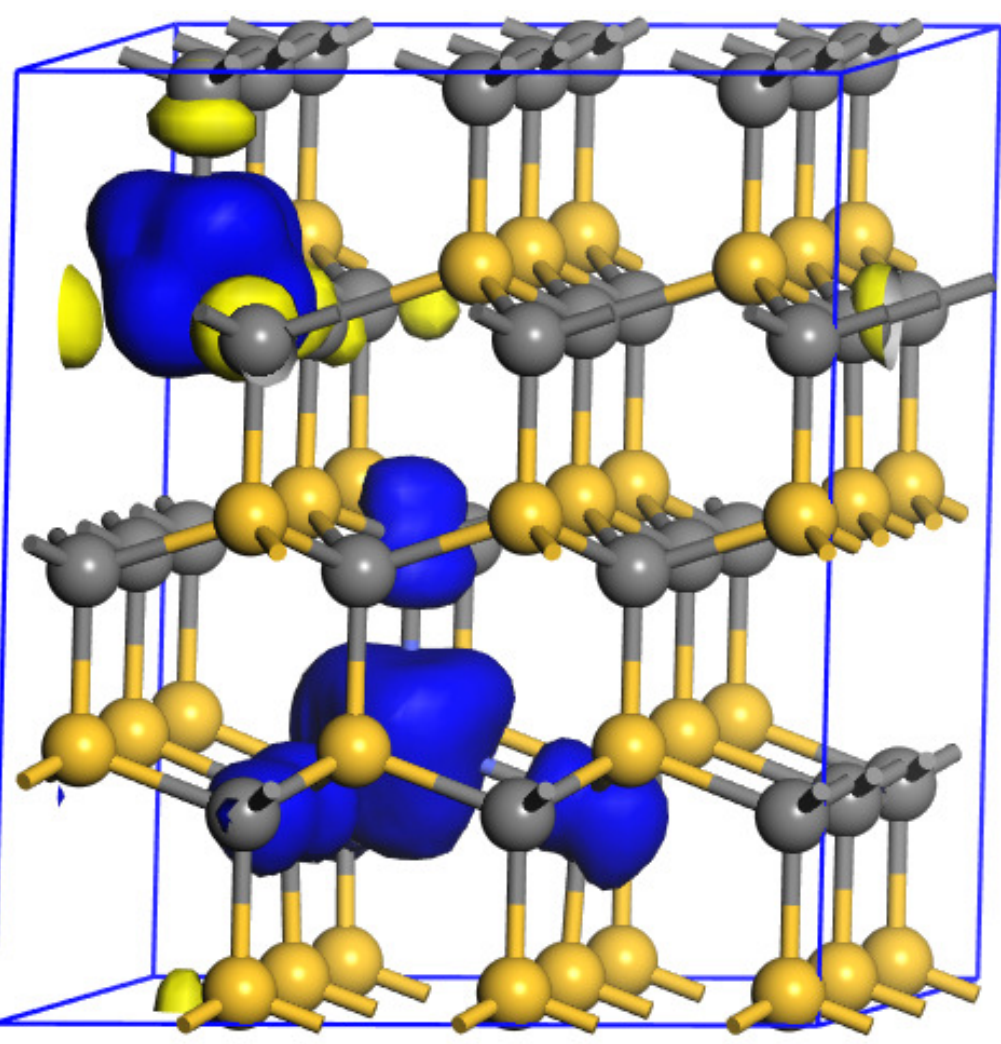
Figure 5. Spin density distribution of (Cr, Co)-codoped 4H–SiC in ferromagnetism coupling. The blue and cyan yellow display positive and negative spin charge density. The isovalue is set to 0.05 e/ 3